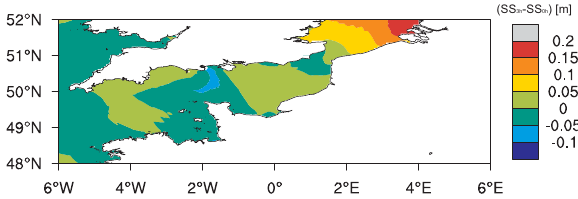
Fig. 9. Difference between high-tide skew storm surges obtained for a meteorological phase-lag of 3h (as compared with the original meteorological conditions) and the skew storm surges obtained for the original meteorological conditions (zero phase-lag). The simulation is performed for a mean spring tide and for the November 2007 event. Data interval: 12-minutes.